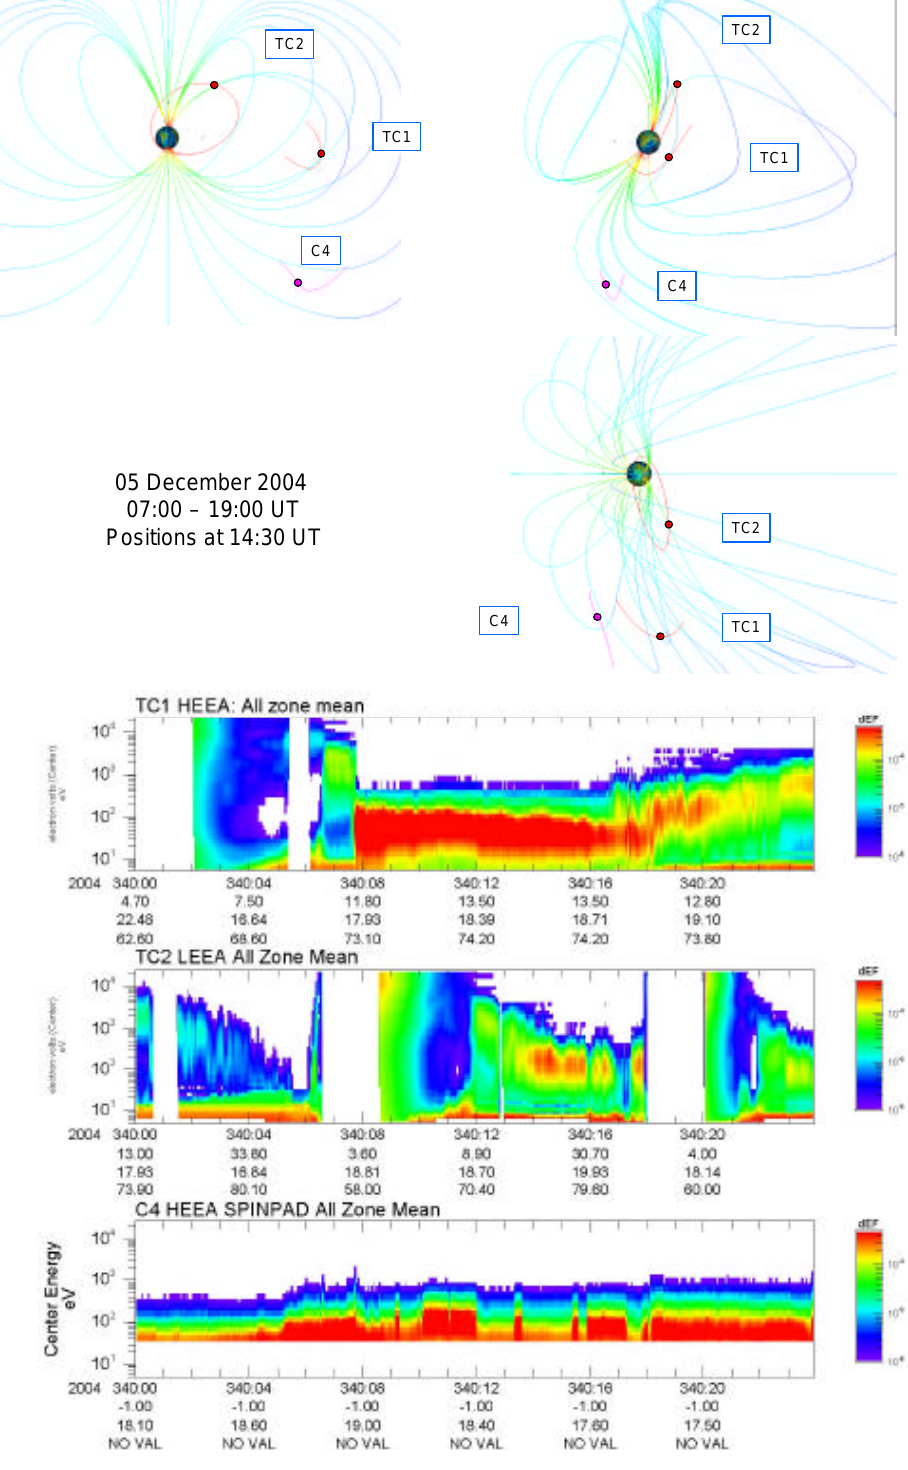
Figure 18: above, December 05 th 2004, orbital positions and OVT model magnetosphere Fig. 18. Above, 5 December 2004, orbital positions and OVT model magnetosphere in GSM, views from X, Y and Z; below, PEACE data in GSM, views from X, Y and Z; below, PEACE data from TC1, TC2 and C4. X-axis from TC-1, TC-2 and C4. X-axis labels show UT time, L-shell, MLT and invariant labels show UT time, L-shell, MLT and invariant latitude.